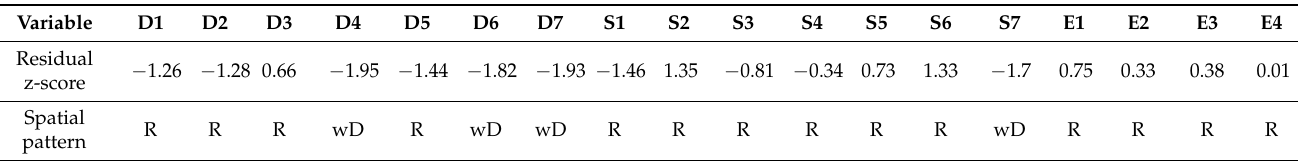
Table 4. Spatial autocorrelation results for GWR residuals. Source: own elaboration on the basis of ArcGIS Pro 2.9 by